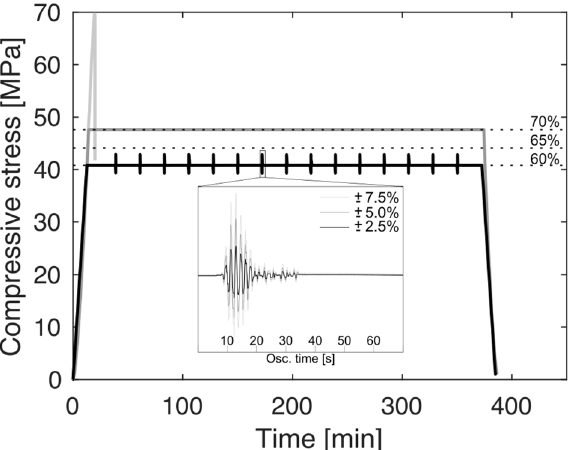
Figure 2. Experimental approach. The light grey curve shows the stress evolution during one of the uniaxial compressive strength (UCS) tests. The dotted lines represent the range of test set points used for proceeding experiments, at 60, 65, and 70% of the average UCS. The dark grey curve shows an example of the stress evolution during a creep experiment with a load hold of 70% of the average UCS. The black curve shows an example of the stress evolution during an oscillation test composed of 15 stressing waves applied at 22-min intervals during a load hold of 60% of the average UCS. The inset shows examples of the waveforms applied. For each oscillation test, one amplitude variation is selected, corresponding to ± 2.5% (black), ± 5% (dark grey) or ± 7.5% (light grey) of the original creep load